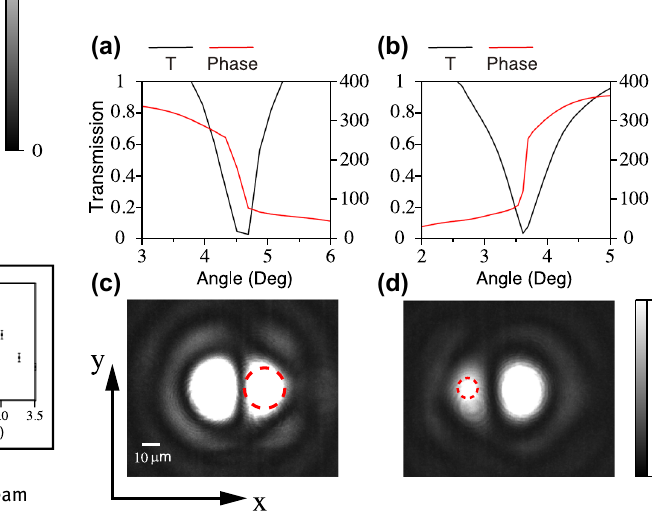
N window. Figure 4: Transmission coefficient of the grating and phase of the 3 4 transmitted field under TE-polarized incidence light at the wavelength (a) 𝜆 = 750.8 nm and (b) 𝜆 = 811 nm. Beam images passing through the grating at the wavelength (c) 𝜆 = 750.8 nm and (d) 𝜆 = 811